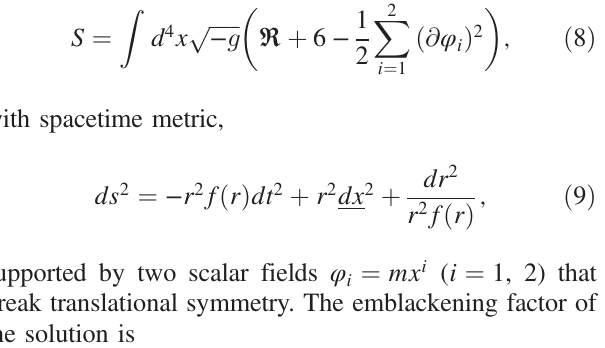
FIG. 1. Frequencies of the hydrodynamic and longest-lived infrared modes at T=m ¼ 10 − 3 . Black circles are numerical results and red lines are the analytic expressions (11) and (13). For real k , all poles displayed have purely imaginary